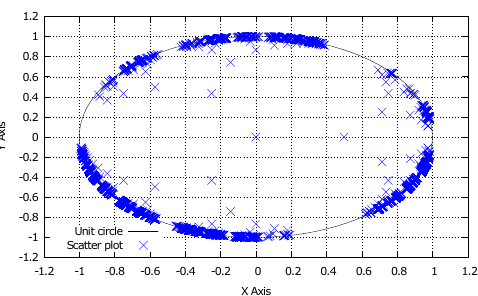
Figure 10. Scatter plot of distributed directories system.